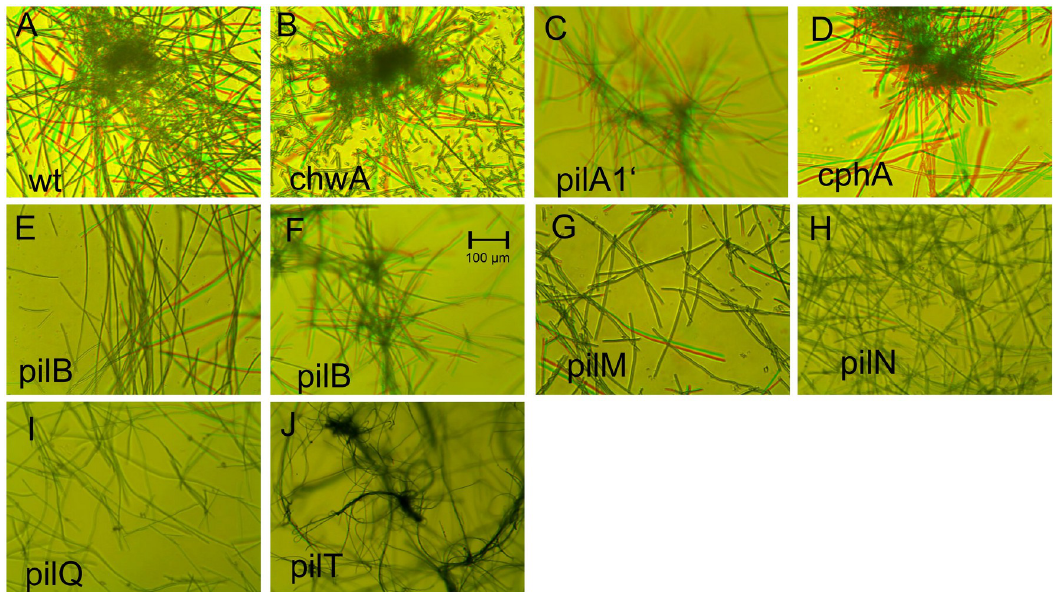
Fig 3. Motility in liquid culture. In each panel, two pictures with red and green false colors are superimposed. The time difference between both was 10 s. Moving filaments are highlighted by red or green color. The name of each mutant is given in the panels. For pilB mutants there are two pictures, E and F, with weak and stronger movement, respectively. See also S2–S10 Movies.